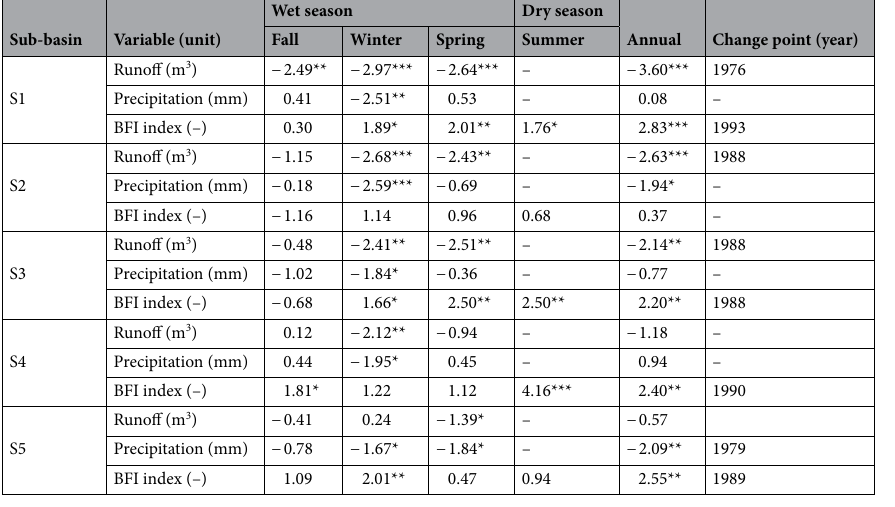
Table 5. Values of Z for precipitation, runoff, and the BFI index in the Dez